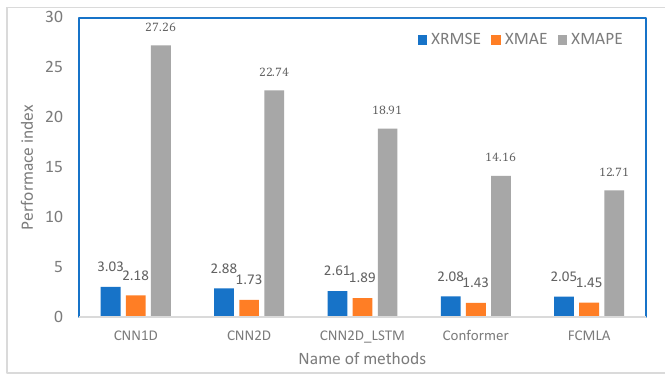
Figure 10. Performance comparison of each model training for 200 rounds.